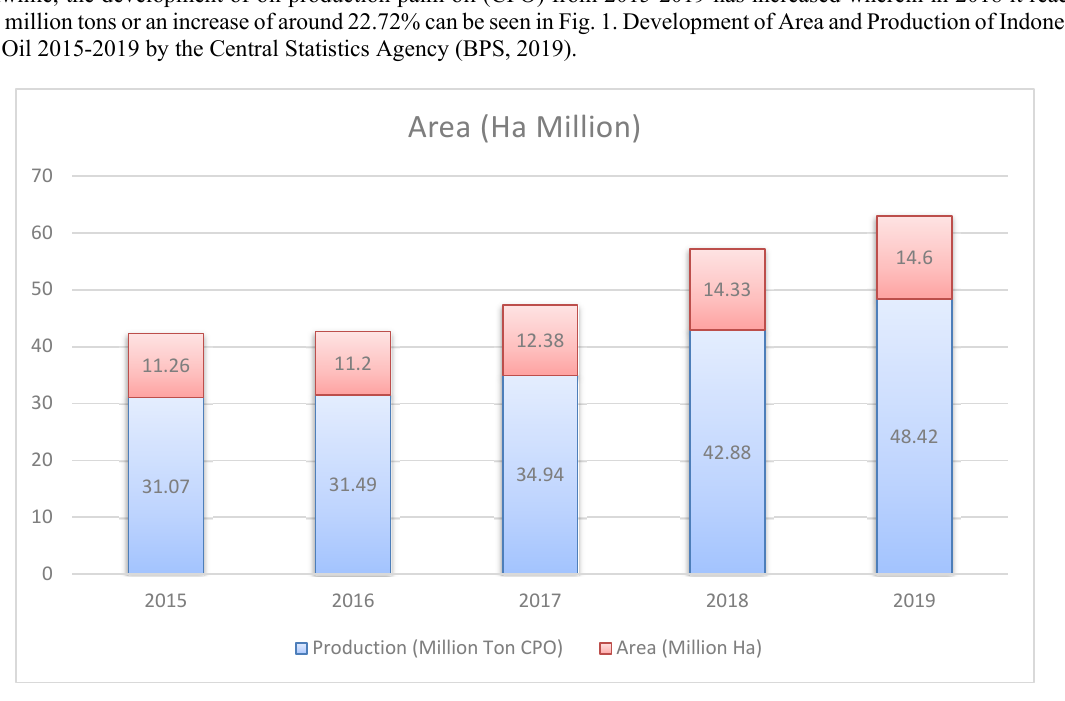
Fig. 1. Development of Indonesian Palm Oil Area and Production 2015-2019 (BPS,